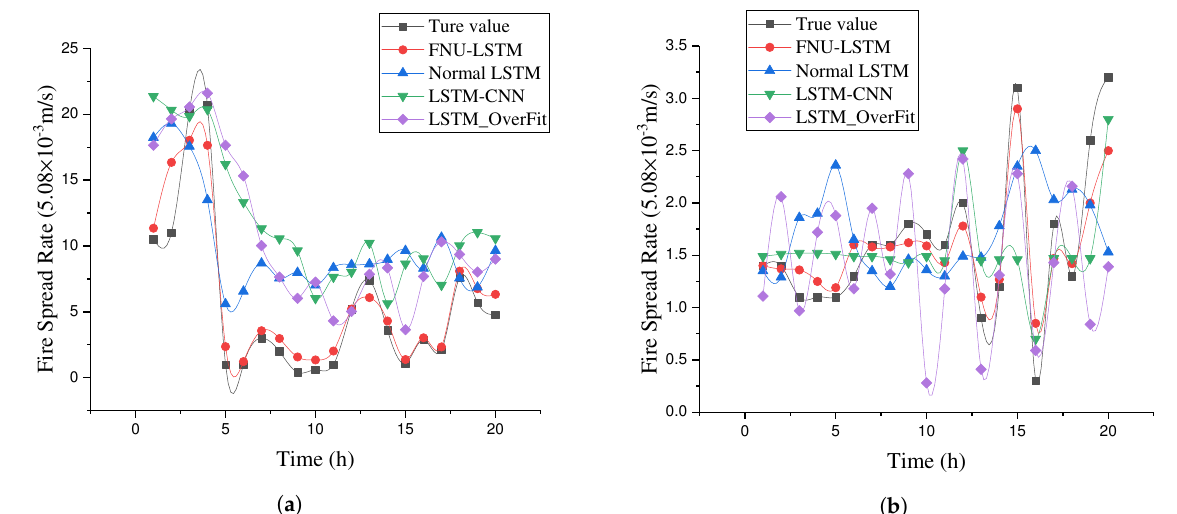
Figure 17. Forest fire spread rate according to the time, predicted from several models. ( a ) Predicting fire rate of the wildland fire Emery. ( b ) Predicting fire rate of the wildland fire Emery DogHead . Table 10. The prediction error RMSE of fire spread rate(wildland fires).